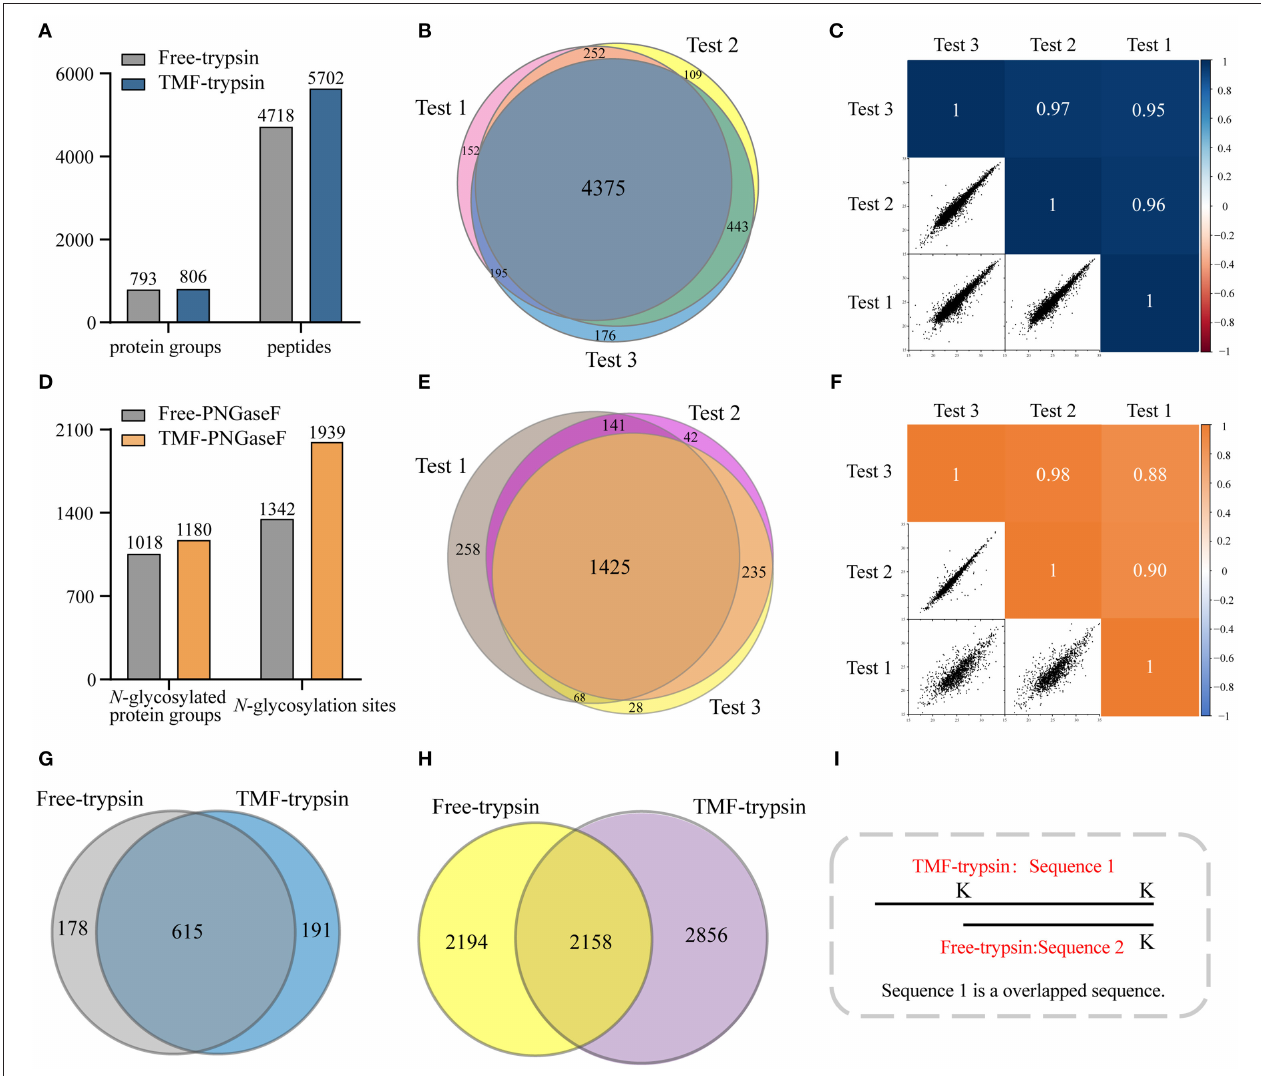
FIGURE 4 | (A) Unique peptides and corresponding proteins identified by free trypsin and TMF–trypsin. (B) Identification reproducibility evaluation of TMF–trypsin by overlapping the identified peptides of three replicates. (C) Quantification reproducibility evaluation of TMF–trypsin. (D) Unique N -glycosylation sites and corresponding N -glycoproteins identified by free PNGase F and TMF–PNGase F. (E) Identification reproducibility evaluation of TMF–PNGase F by overlapping the identified peptides of three replicates. (F) Quantification reproducibility evaluation of the TMF–PNGase F. (G) Overlap of the proteins identified by free-trypsin and TMF–trypsin. (H) Overlap of the peptides of the 615 co-identified proteins by free-trypsin and TMF–trypsin. (I) Schematic diagram of overlapped sequence caused by missed cleavages.